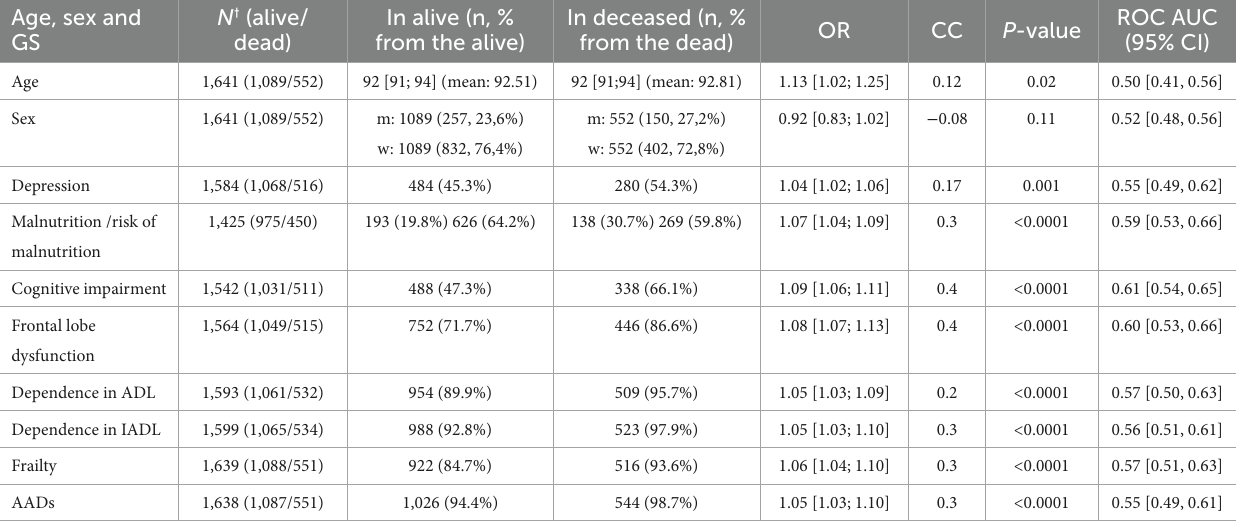
TABLE 3 Associations between the GSs and 1-year all-cause mortality (only significant), adjusted for sex, age, and multiple testing. Age, sex and N † (alive/ In alive (n, % In deceased (n, % GS dead) from the alive) from the